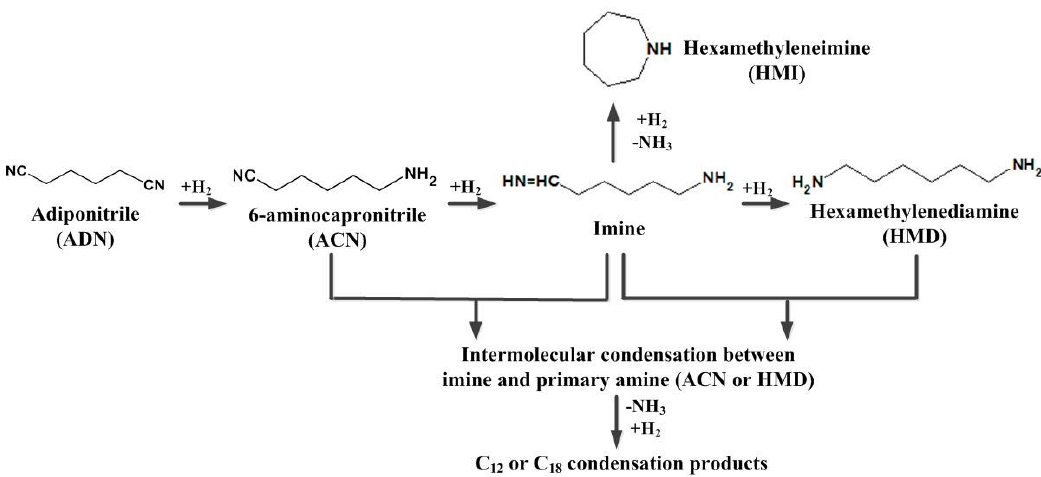
Figure 1. Mechanism of ADN hydrogenation.